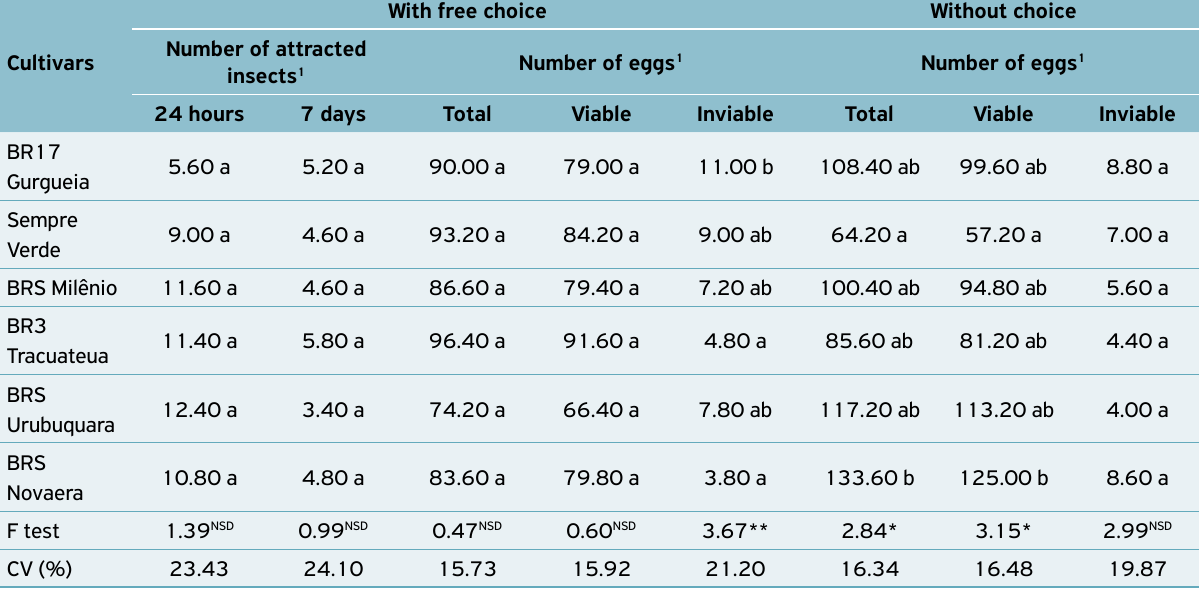
Table 1. Average number of Bruchidius atrolineatus adults attracted and number of viable, inviable and total eggs in seeds of cowpea cultivars in tests with and without choice. Temperature: 25 ± 1ºC; relative humidity: 70 ± 10%; photoperiod: 12 hours. Jaboticabal, SP, 2012.